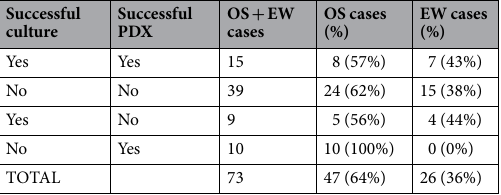
Table 3. Concordance between successful in vitro culture from patient specimen and successful PDX, by tumor type * . * Each line adds to 100%.